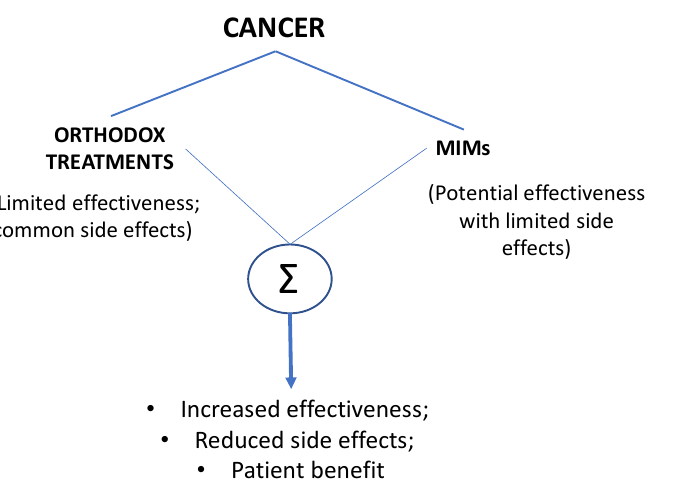
Figure 1. A conceptual representation of the relative advantages of combining orthodox treatments of cancer with modulators of ionic mechanisms (MIMs). ‘ Σ ’ indicates combination.